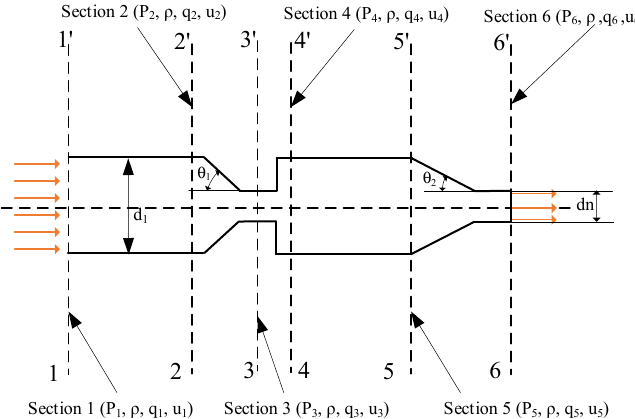
Figure 5. The simplify the flow pipe of the nozzle.